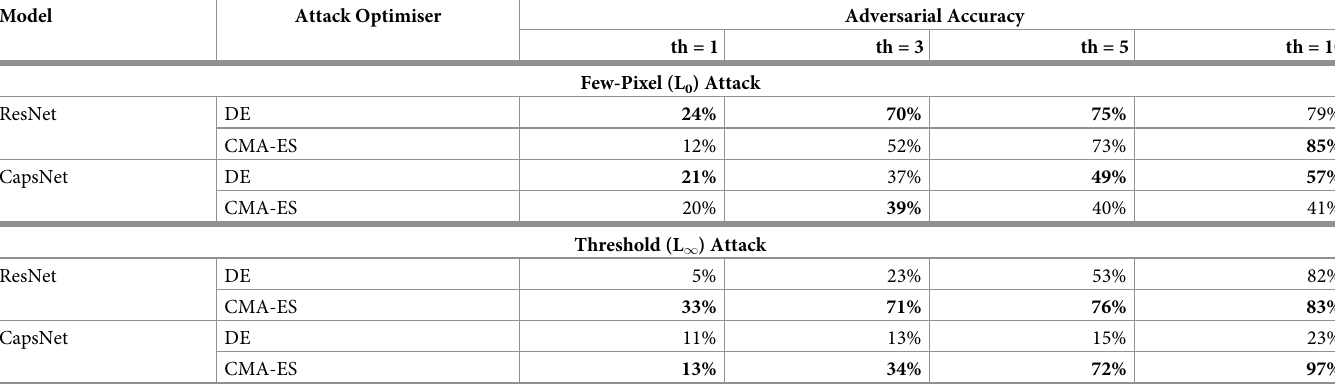
Table 4. Adversarial accuracy results for Few-Pixel ( L 0 ) and Threshold ( L 1 ) attacks with DE and